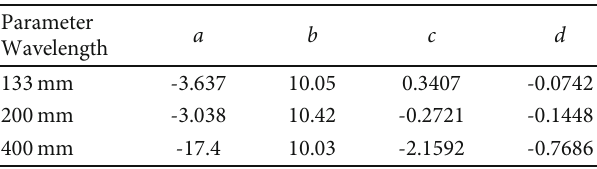
Figure 14: x -direction force on the dorsal fi n at di ff erent wavelengths. Table 7: x -direction force parameter values of the dorsal fi n at di ff erent